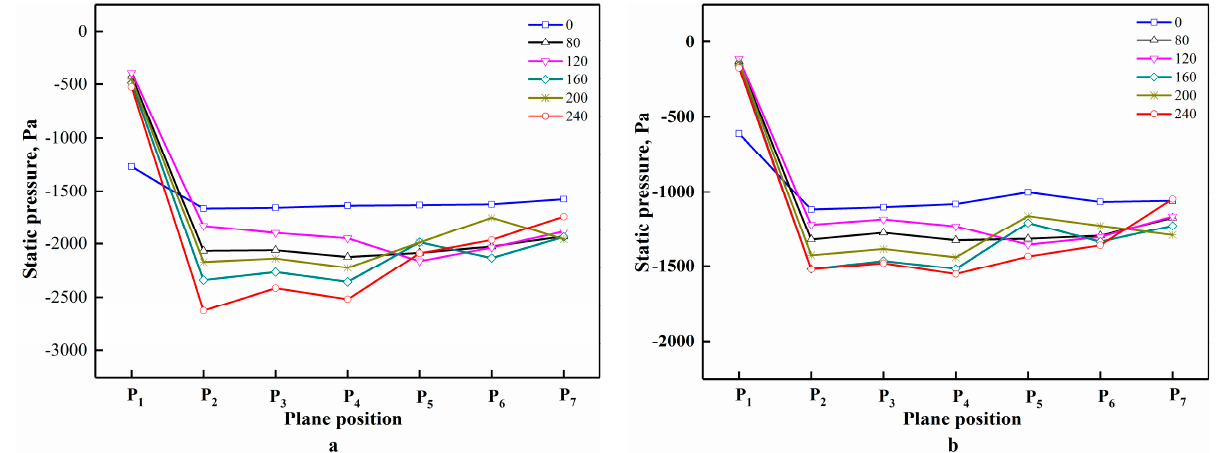
Figure 11. Sketch map of plane position.